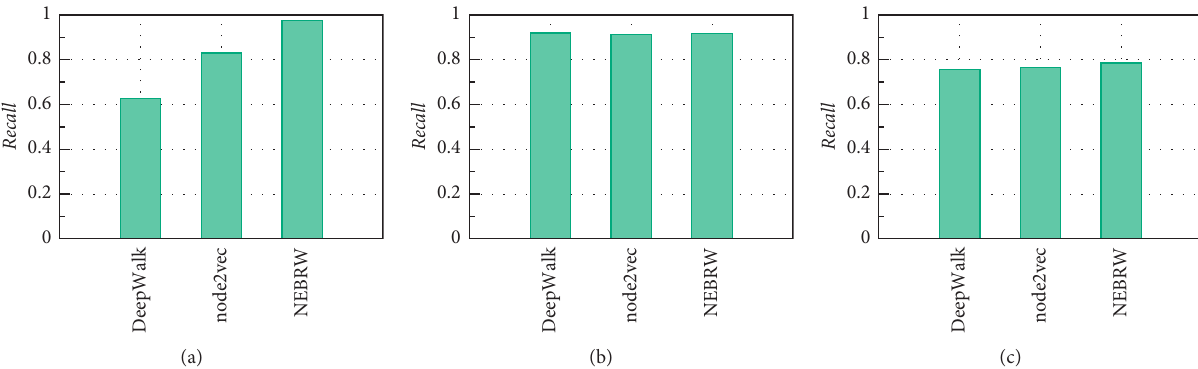
Figure 7: Comparison results on real-world networks with node embedding baselines. (a) Comparison result on Karate. (b) Comparison result on Football. (c) Comparison result on Polbooks.